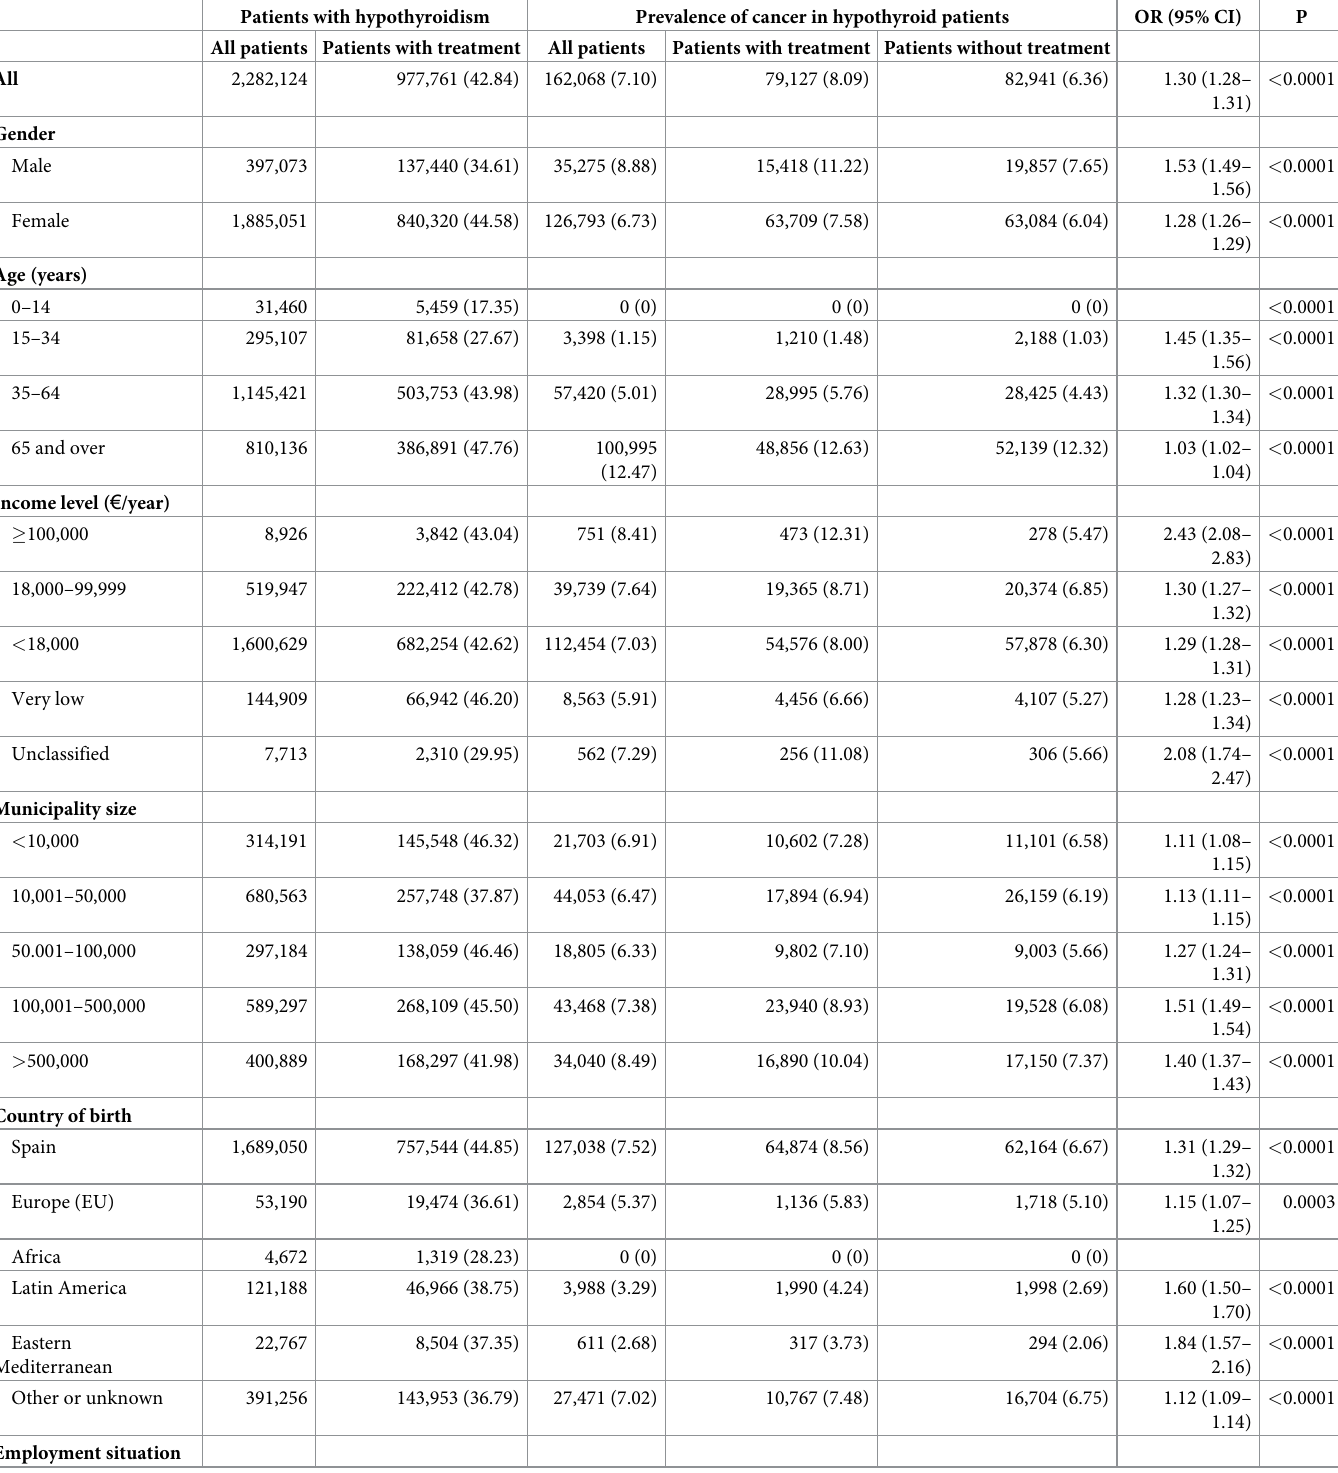
Table 4. Prevalence of cancer in patients with hypothyroidism classified according to the presence or absence of treatment with thyroid hormones (data of 2018). Patients with hypothyroidism Prevalence of cancer in hypothyroid patients OR (95% CI) P All patients Patients with treatment All patients Patients with treatment Patients without